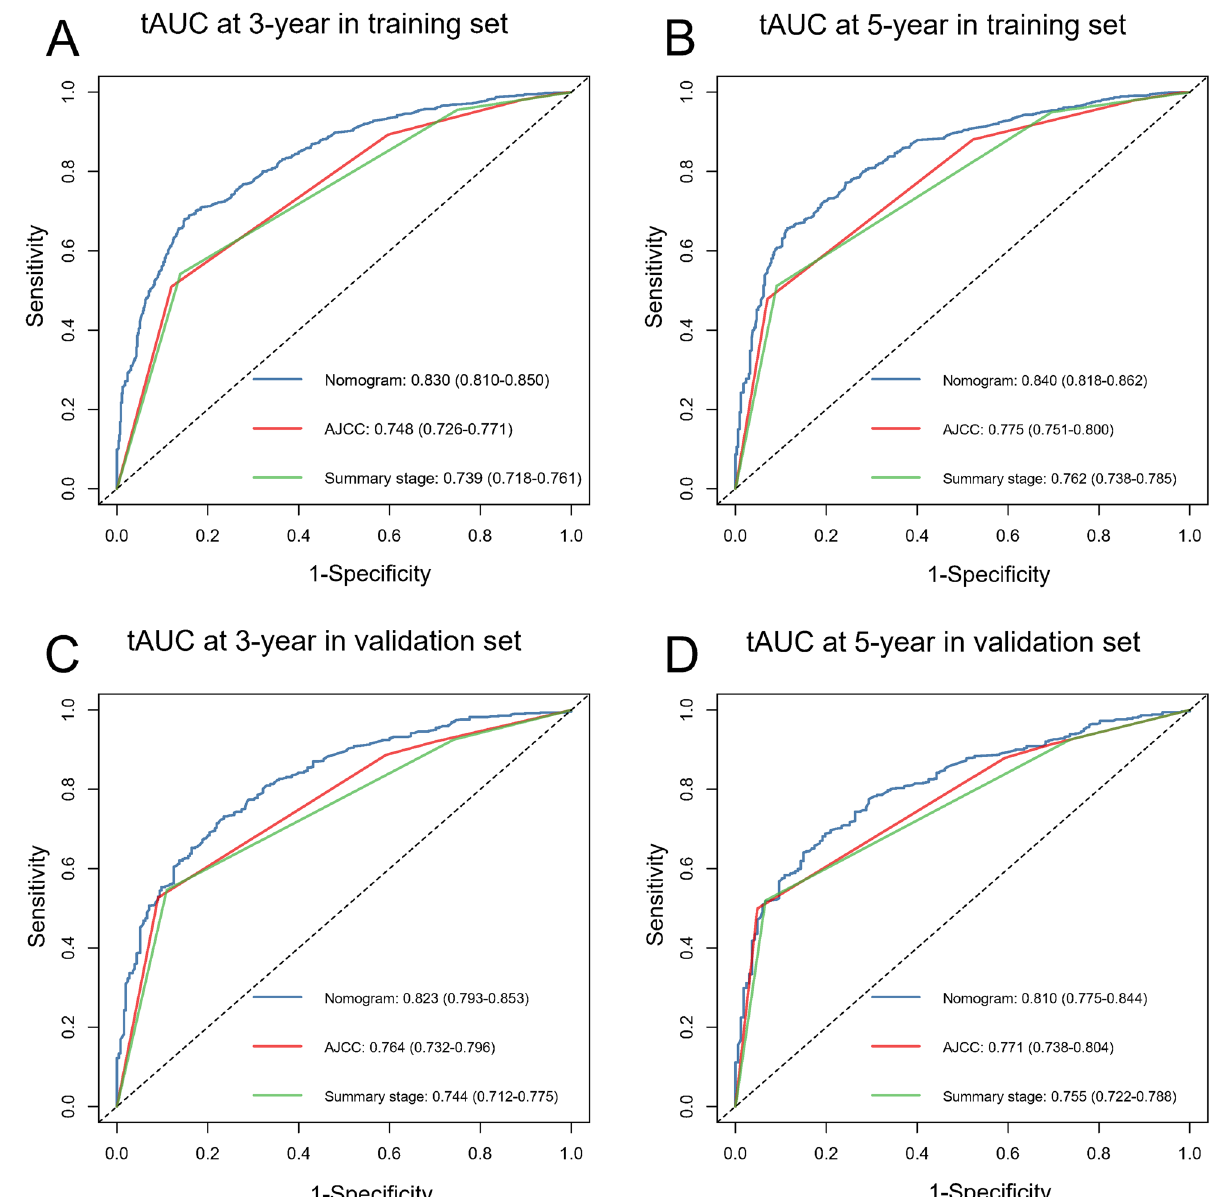
Figure 4. Discriminatory accuracy for predicting OS assessed by receiver operator characteristics (ROC) analysis calculating time independent area under the curves (tAUCs). 3-year ( A ) and 5-year ( B ) in the training cohort; 3-year ( C ) and 5-year ( D ) in the validation